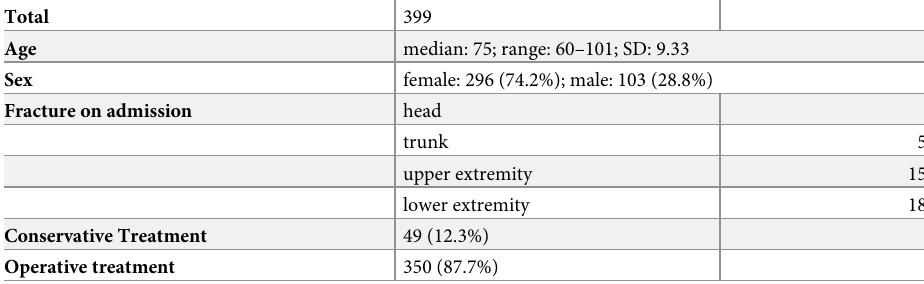
Table 1. Demographic data, fractured region on admission, type of treatment